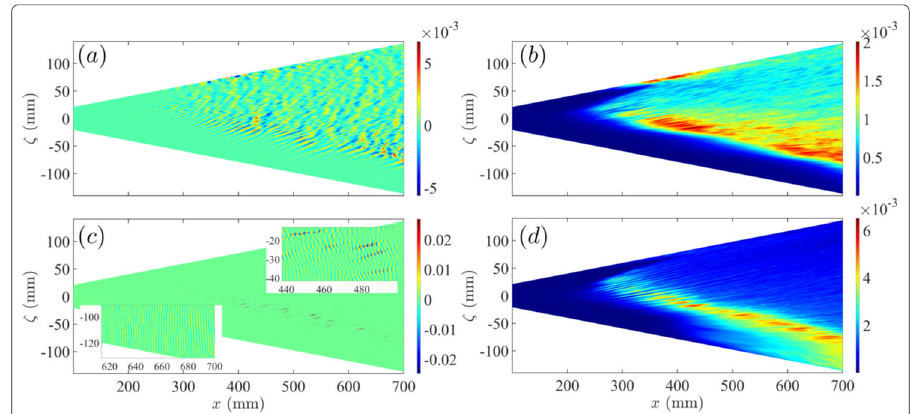
Fig. 7 The instantaneous a , c and r.m.s. b , d of low- and high-frequency p w . a , b for low-frequency p w with frequency 10-50 kHz and c , d for high-frequency p w with 300-600 kHz. Details of high-frequency p w are given in two regions by the